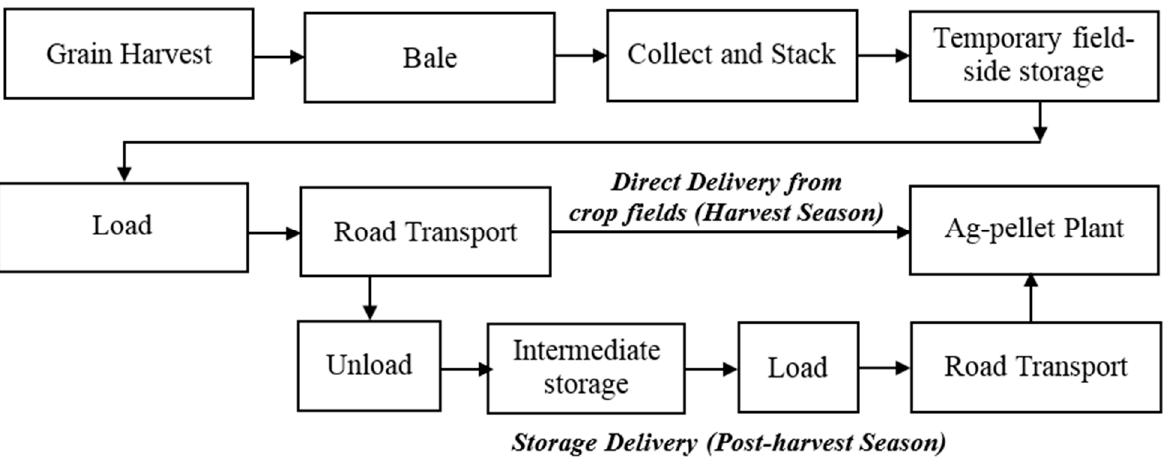
Energies 2021 , 14 , x FOR PEER REVIEW 5 of 21 Figure 2. Sequence of operations in the upstream biomass logistics in the ag-pellet supply chain (adapted from [44,45]).